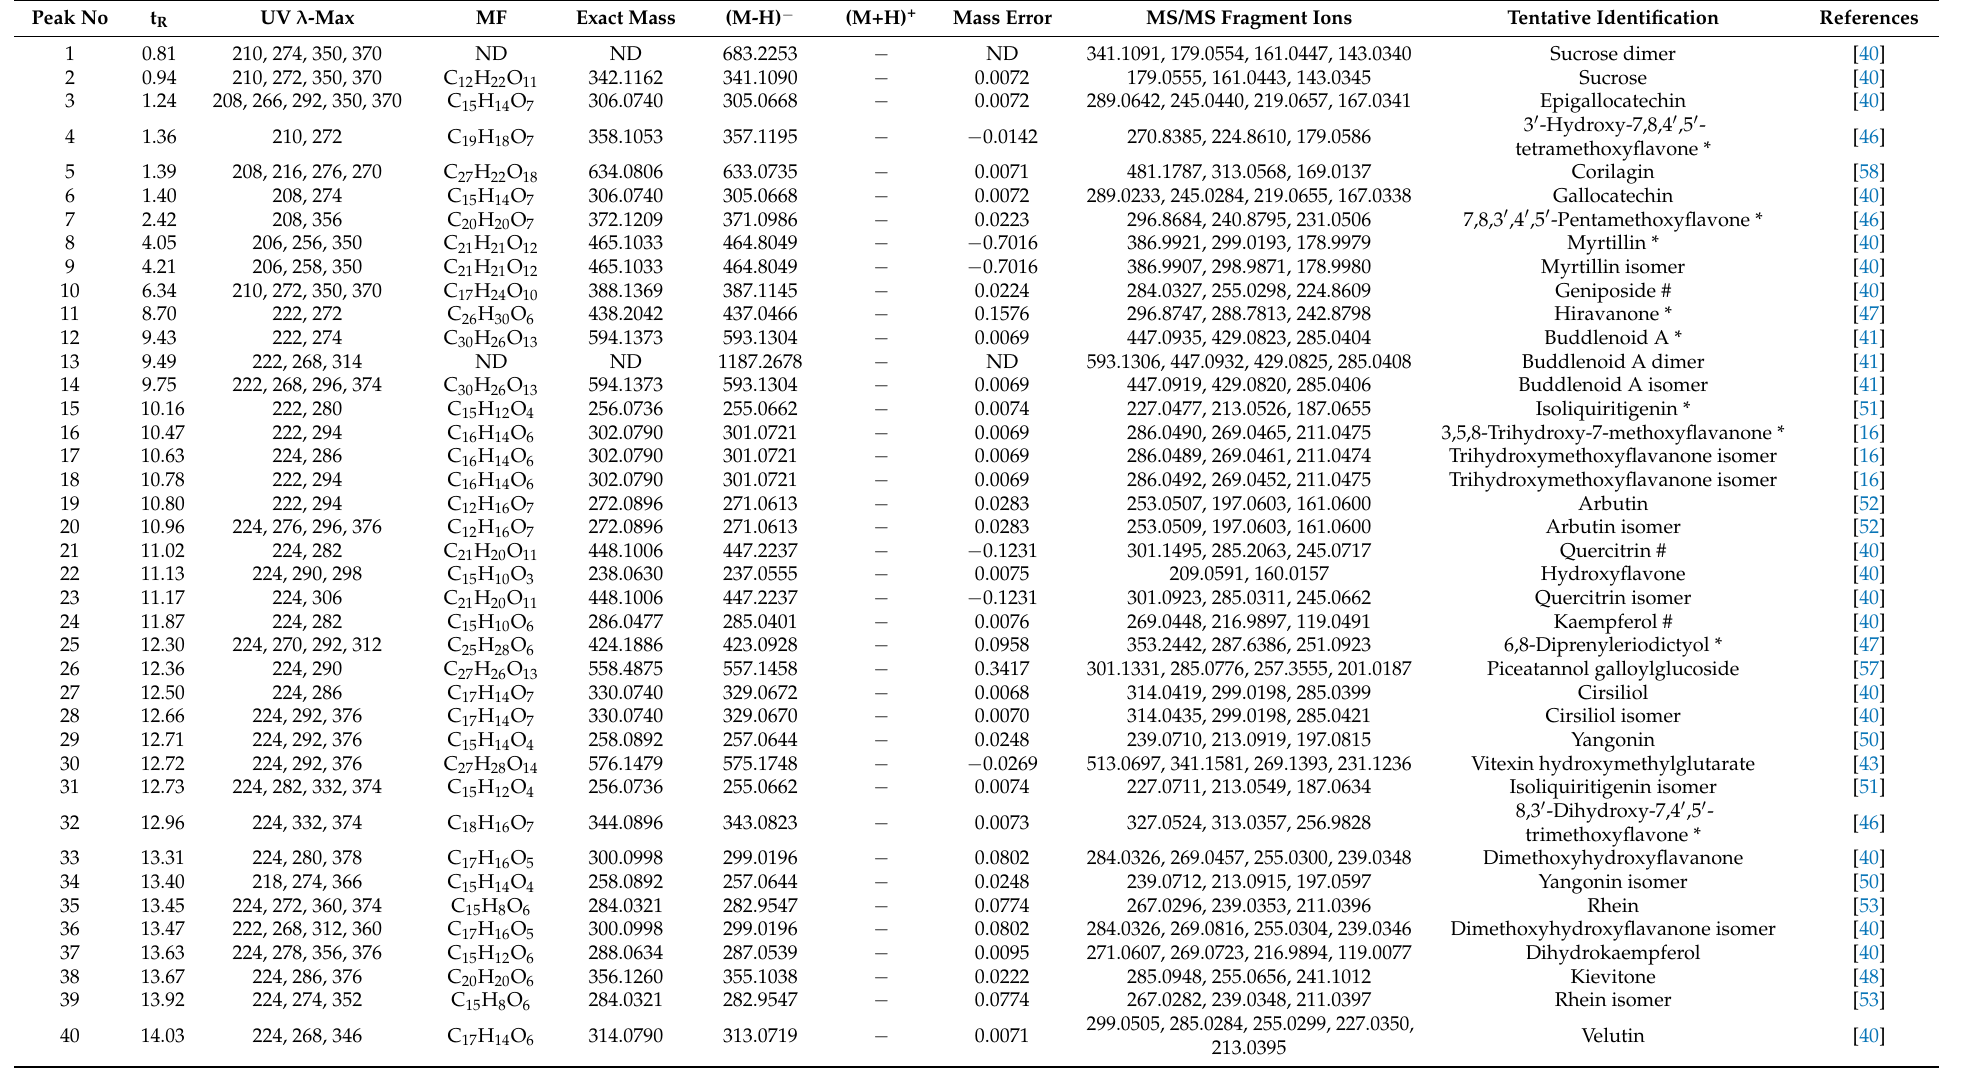
Table 2. Tentative identification of compounds present in M. calabura FD leaves extracted with 50%